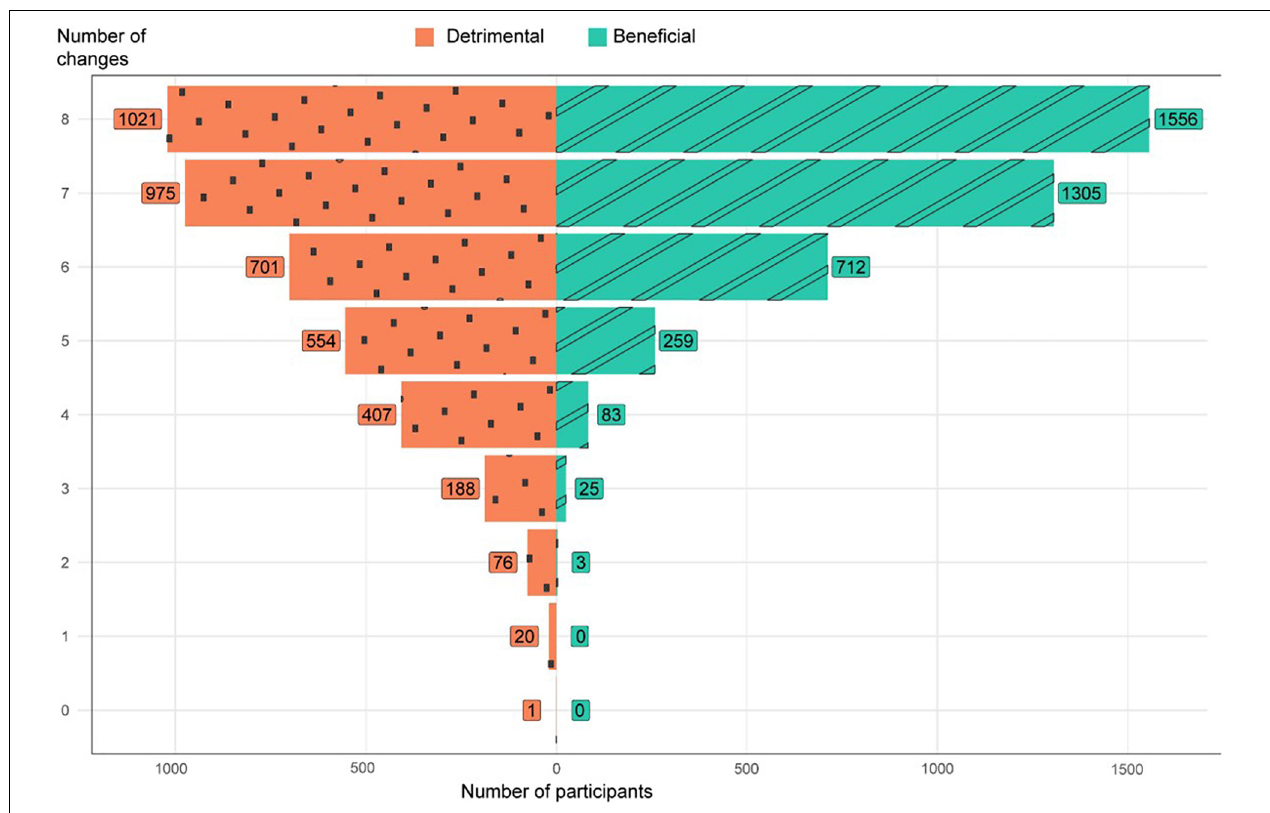
FIGURE 2 | Frequencies of participants reporting number of detrimental or beneficial changes on modifiable factors related to brain health after one year of COVID-19 restrictions ( n =